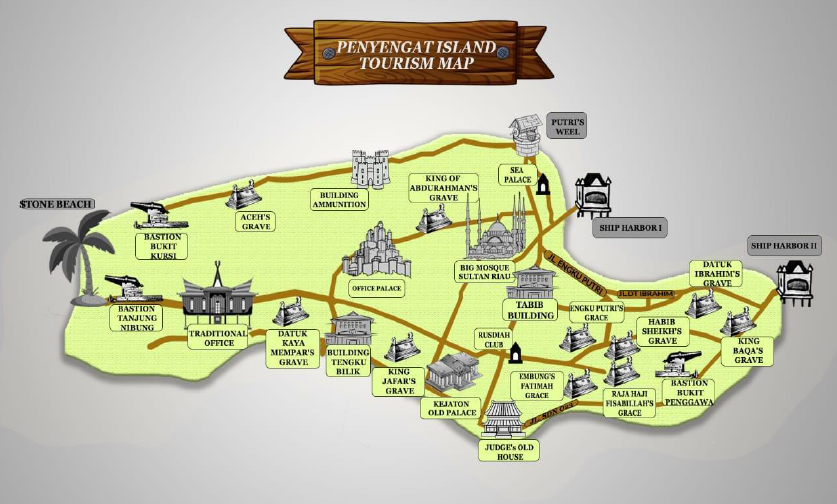
Figure 3. Map of the distribution of tourism objects in Penyengat